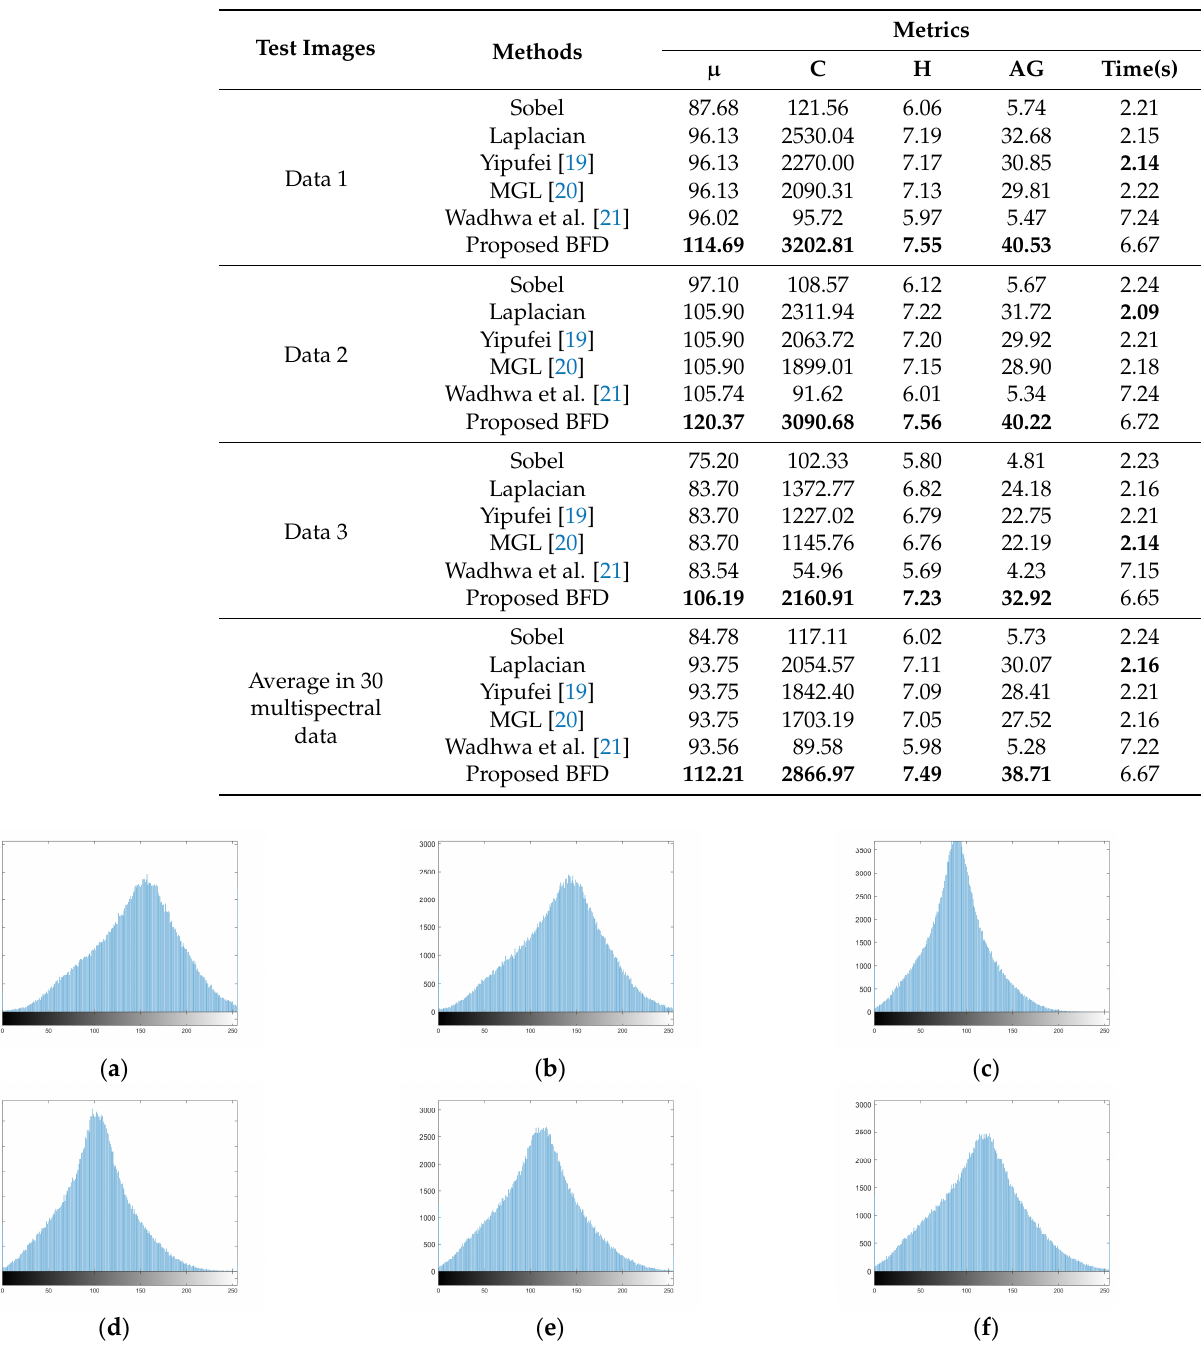
( b ) Figure 11. The quantitative results of different input bands combinations used in 30 multispectral data: ( a ) entropy; ( b ) average gradient. 4.5. Comparative Experiments of Other Methods Based on Image Enhancement We compared the lasting image enhancement methods with our whole algorithm, such as the Retinex-Net approach, the LIME approach, and the ACSEA approach, which as shown in Figure 12 and Table 7. As shown in Figures 12a,b, the Retinex-Net approach and the LIME approach make the overall image brighter, but the sharpness is relatively lower. There are low contrast and loss of detail in the Retinex-Net approach, while satu- ration artifacts appear in the LIME approach. This is because the above methods are mainly used for low illumination image enhancement. Although they greatly improve the image brightness, they cannot preserve the edge details of the image well. In addition, Figure 12c shows that the ACSEA approach has uniform brightness but has relatively